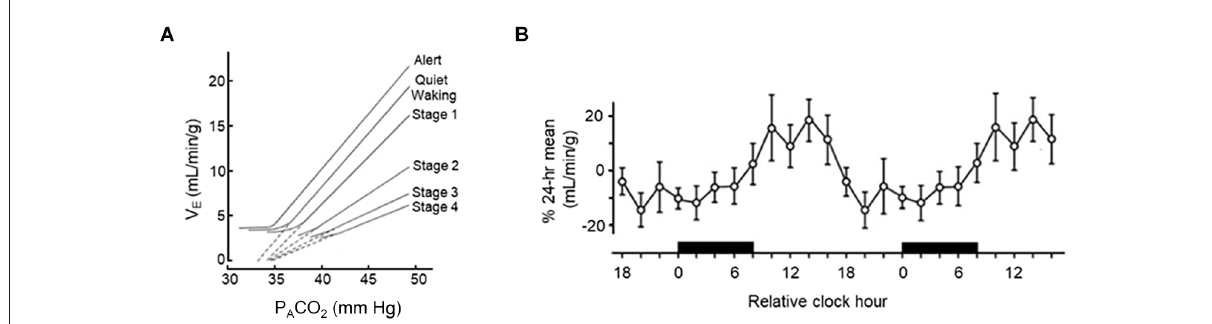
FIGURE3 Circadian and sleep state-dependent effects on the hypercapnic ventilatory response (HCVR). (A) 48-h trace of circadian variations in HCVR in adult humans. (B) Sleep state-dependent differences in HCVR in adult males. (A) Redrawn with permission from Spengler et al. (2000). (B) Redrawn with permission from Bulow